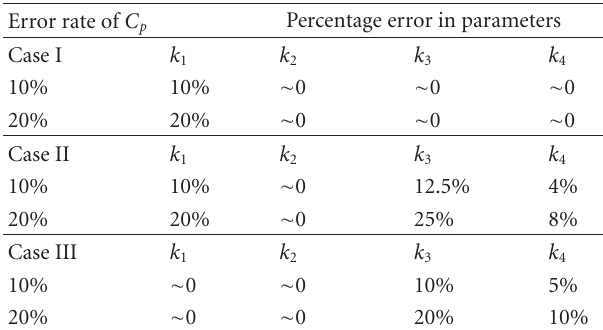
Table 1: The percentage error in estimated k 1 , k 2 , k 3 , and k 4 of liver a ff ected by a range of erroneous blood functions in three cases.